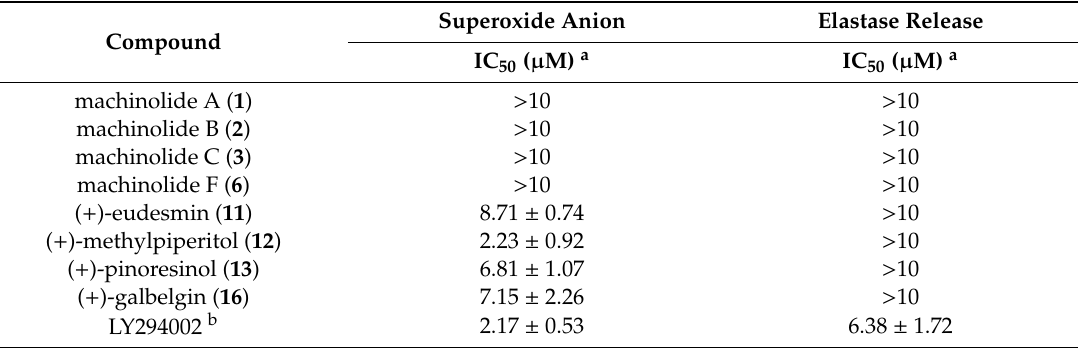
E ff ect of compounds on superoxide anion generation and elastase release in fMLP / CB-stimulated human